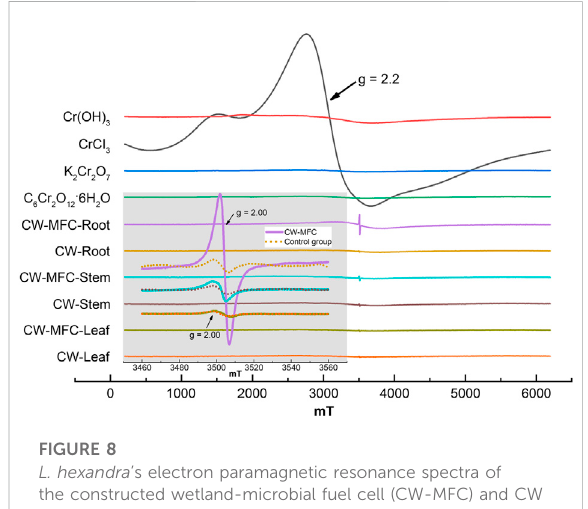
FIGURE 8 L. hexandra ’ s electron paramagnetic resonance spectra of the constructed wetland-microbial fuel cell (CW-MFC) and CW systems.